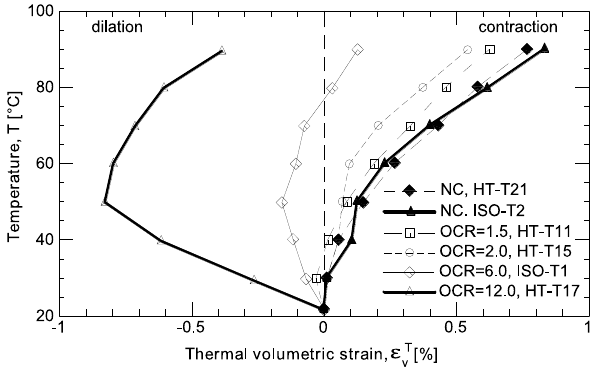
Figure 24. Thermal volumetric strain of speshwhite Kaolin clay during drained heating from 22 ° C to 90 ° C [25].